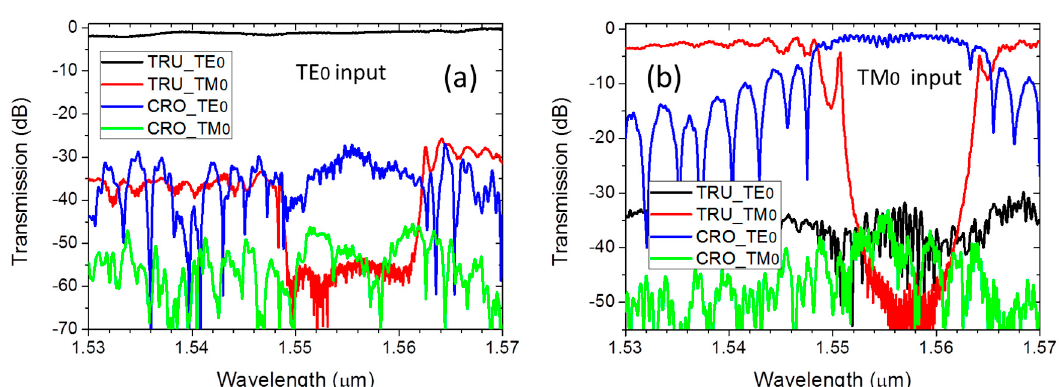
Figure 12. ( a ) Measured transmission spectra of the fabricated PSRs at through port and ( b ) cross port when TE 0 and TM 0 mode are launched.